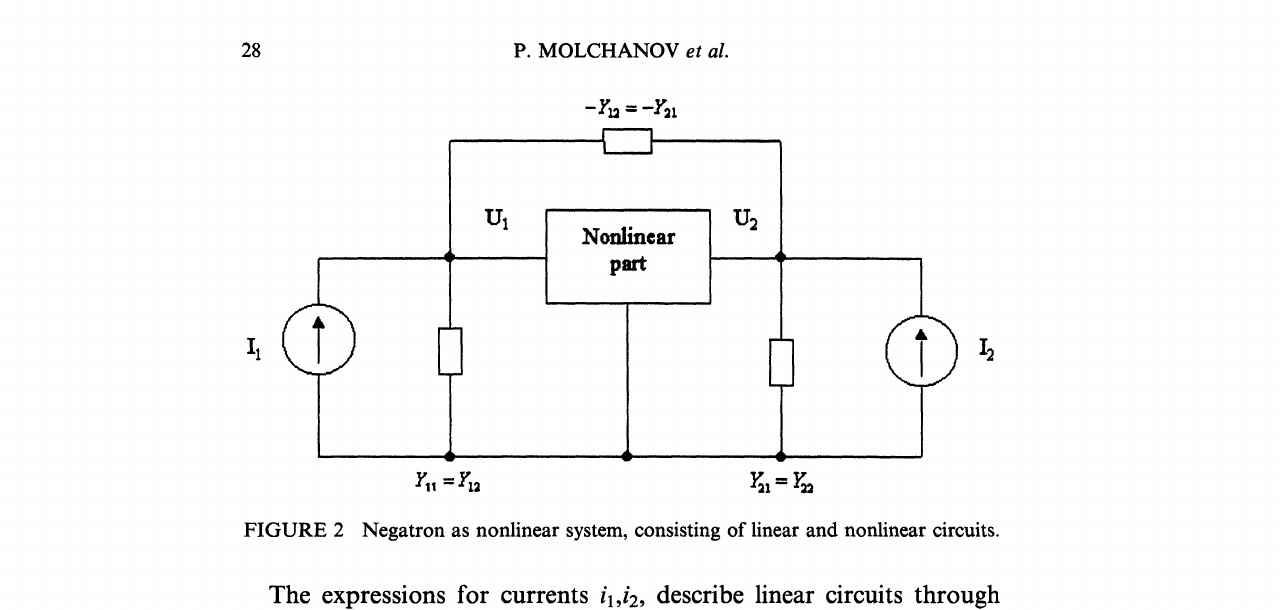
FIGURE 2 Negatron as nonlinear system, consisting of linear and nonlinear circuits. The expressions for currents i1,i2, describe linear circuits through the convolution of pulse-periodical function (Volterra series) for the stationary